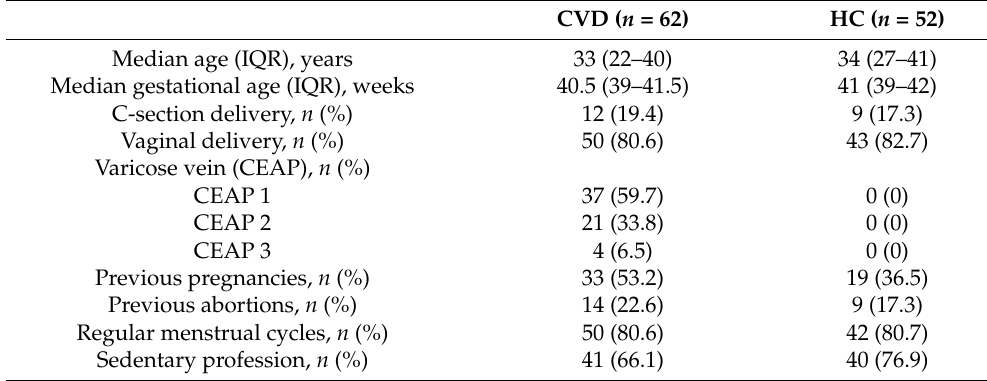
Table 1. Clinical and demographic characteristics. CVD = Chronic venous disease, HC = Healthy